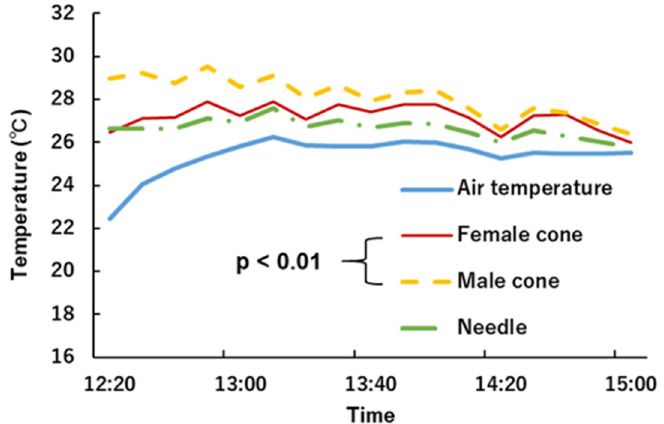
Fig 7. Temperature measurements of Pinus thunbergii . Asterisks indicate a significant difference between male and female cones.